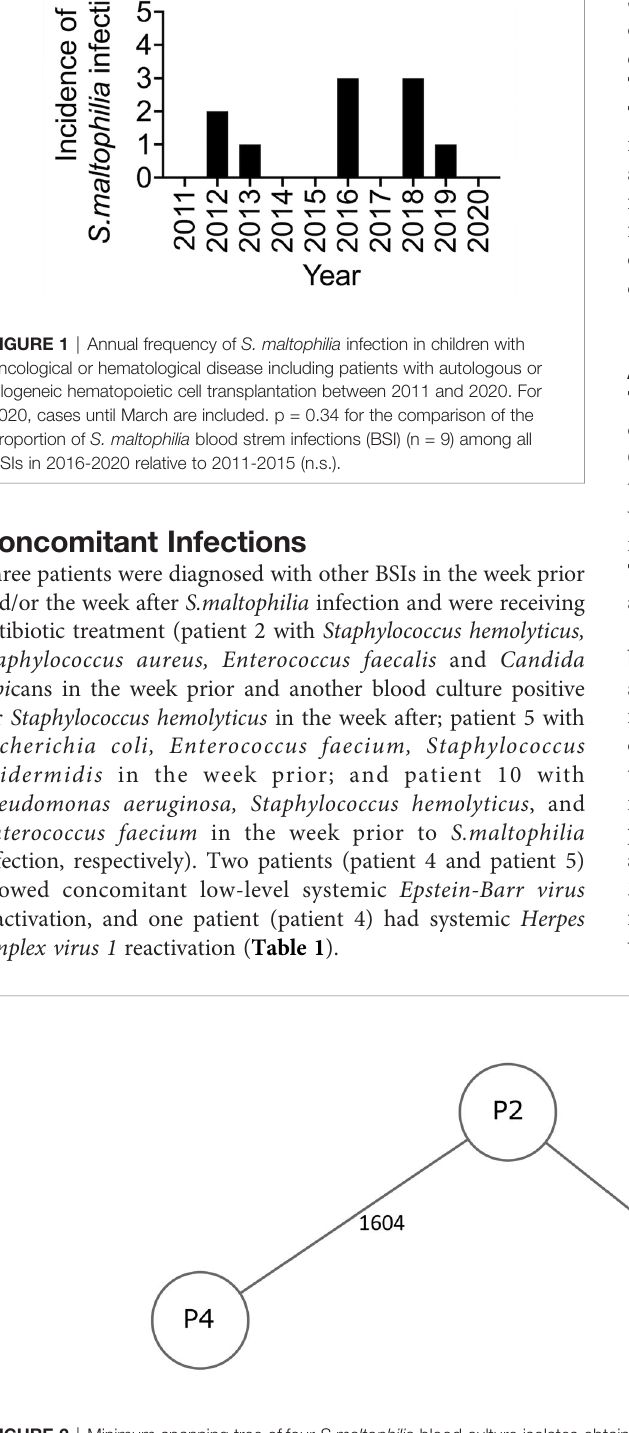
FIGURE 2 | Minimum spanning tree of four S.maltophilia blood culture isolates obtained from four different patients. The tree is based on up to 1876 target genes, pairwise ignoring missing values. Each dot represents one genotype (P1-P4). Different connecting lines and numbers on these lines show the number of alleles differing between two